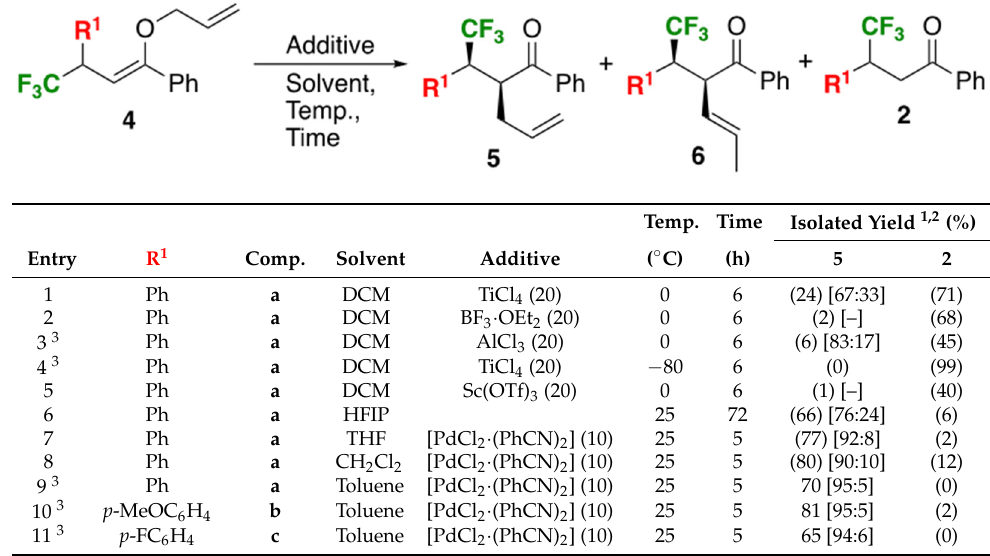
Table 4. Claisen rearrangement of 5 mediated by additives.